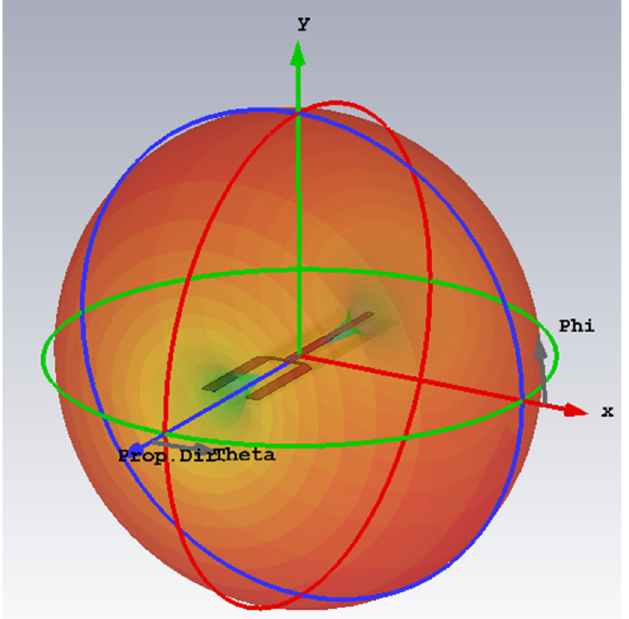
Figure 5. Simulation results of collinear antenna’s gain.